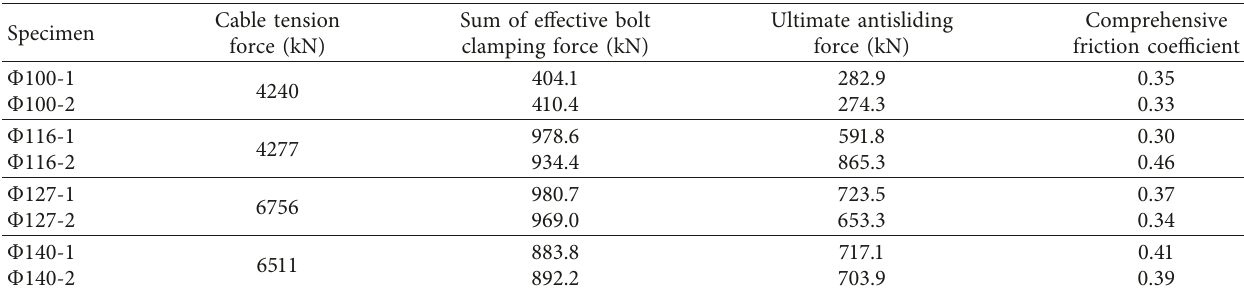
Table 4: Ultimate antisliding force and comprehensive friction